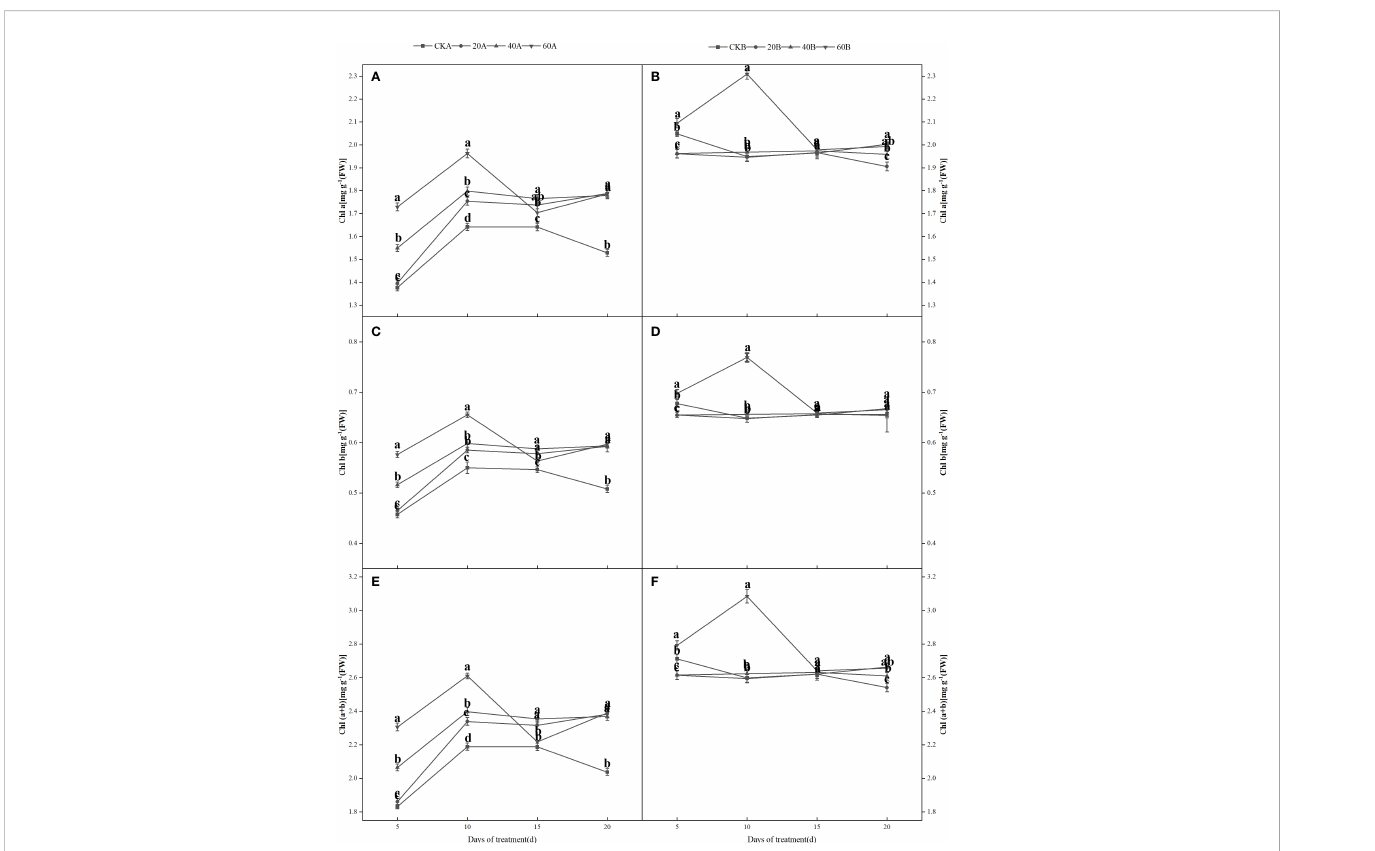
FIGURE 4 Effects of GA 3 application on the Chl a (A, B) , Chl b (C, D) , and Chl a+b (E, F) contents of different light-sensitive inbred maize lines under low light stress. Values are expressed as mean ± SD of three replicates. Lower-case letters indicate the mean difference of different treatments in the same period, which is statistically signi fi cant